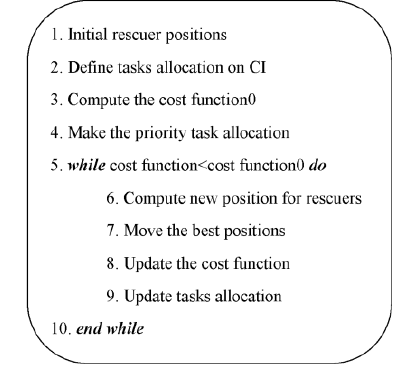
Figure 4: The pseudo-code of the context-aware